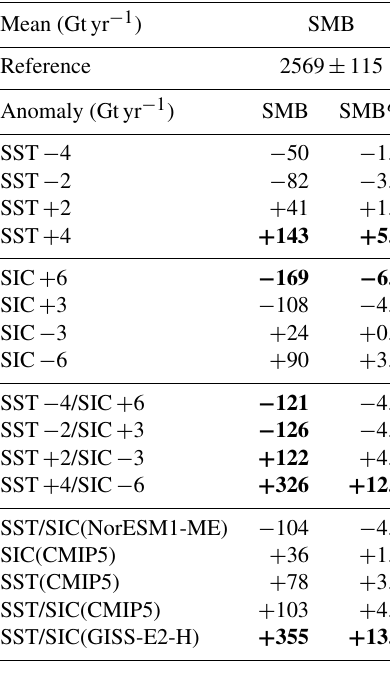
Table 2. Top: annual mean integrated (Gtyr − 1 ) and standard deviation (Gtyr − 1 ) SMB, precipitation, water fluxes (sublimation and depo- sition processes), and surface meltwater production over the whole AIS (including grounded and floating ice) for the reference run (1979– 2015). Positive water fluxes represent a mass loss through sublimation and evaporation while negative water fluxes are representative of deposition processes. Bottom: Difference of annual mean integrated SMB (Gtyr − 1 and %), its components, and meltwater (Gtyr − 1 ) be- tween each sensitivity test and the reference simulation (1979–2015). Anomalies larger than the interannual variability are considered as significant and are displayed in